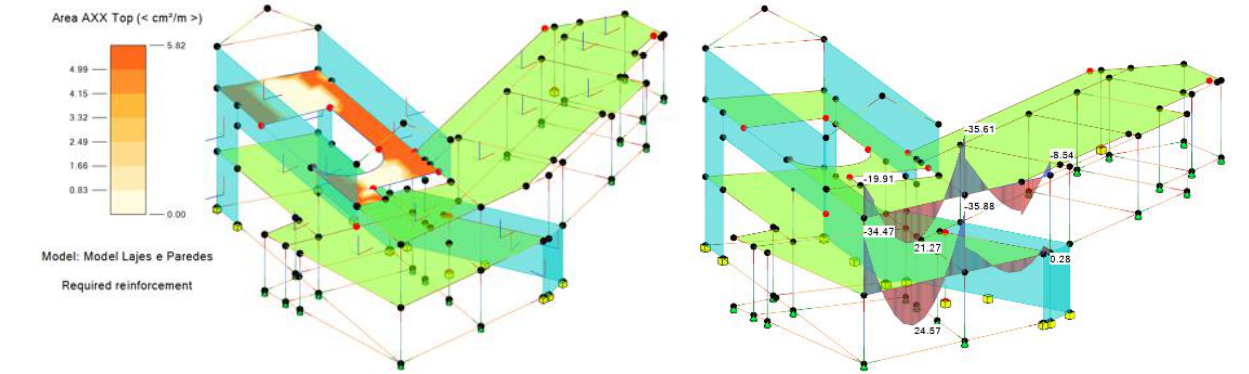
Figure 16. Required reinforcement area in slab floor 2 and in beams.